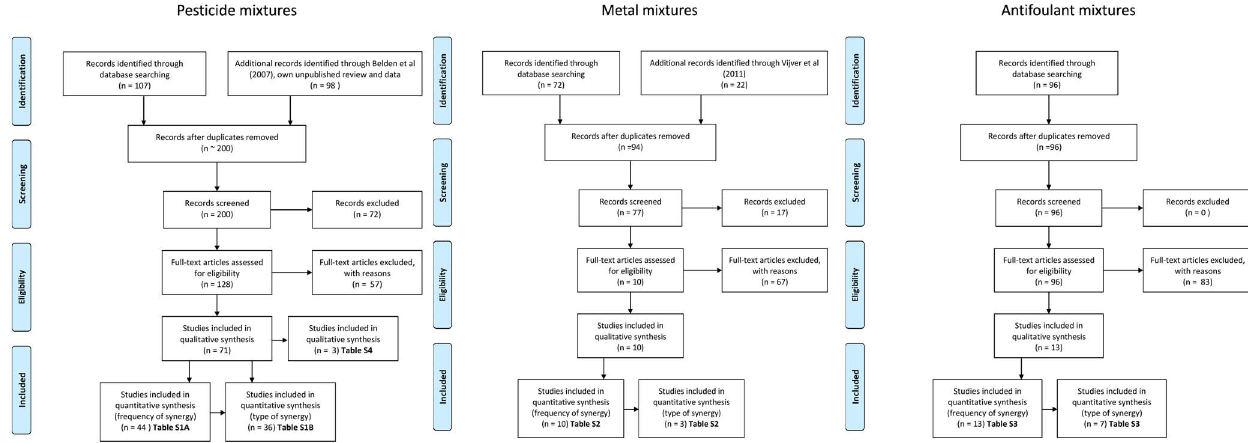
Figure 1. PRISMA 2009 Flow Diagram [90] . A flow diagram depicting the process of selection of records used in the review for the three main groups of toxicants: Pesticides, metals and antifoulants. Data selection has, for pesticides and metals, been built on previous reviews and data compilations, given in the top right text-box, supplemented with database searched using ISI Web of Science. Search criteria and criteria for selecting eligible records are given in the Material and Methods section. For each toxicant the search resulted in two types of databases: One to determine the frequency of synergy in a randomly selected number of mixtures studies, and another focussing only on defined synergistic mixtures. It should be noted that many records contain data on several independent mixtures studies; hence the number of records given in the figure does not match the number of selected studies reported in the results section. References to tables in supporting material giving the raw data on specific chemical mixtures, test species, endpoint and timecourse of the experiment, and the record providing the information are given in the figure.